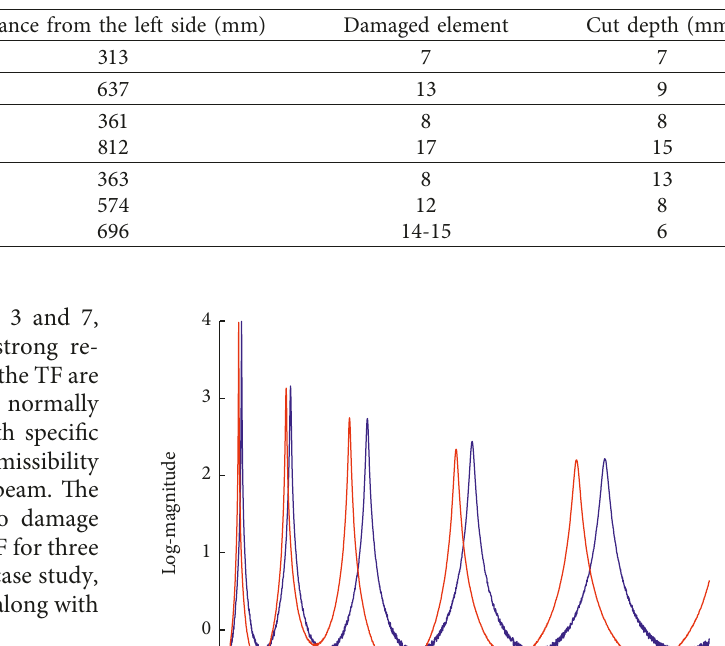
Table 4: Experimental beam damage scenarios.